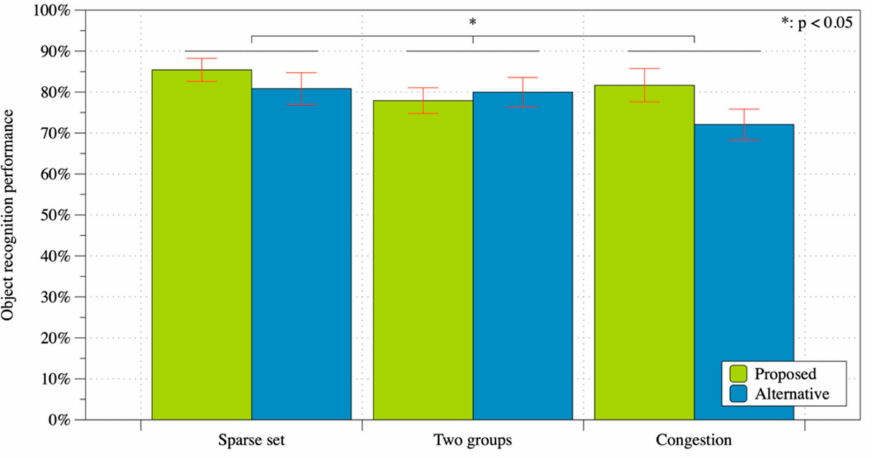
Figure 12. Performance of object reference recognition with standard error of Experiment 1.